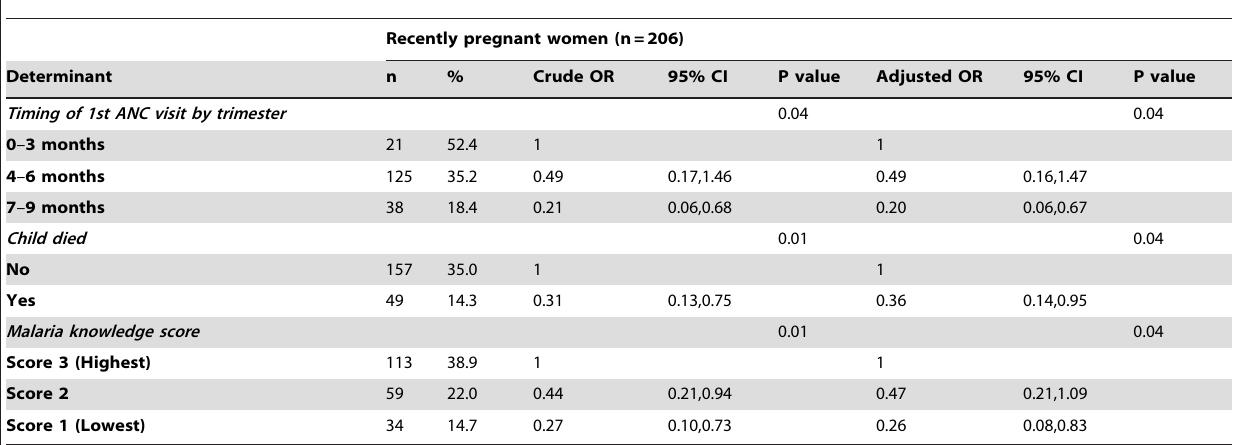
Table 5. Univariate and multivariate analysis of predictors of receiving two doses of IPTp among recently pregnant